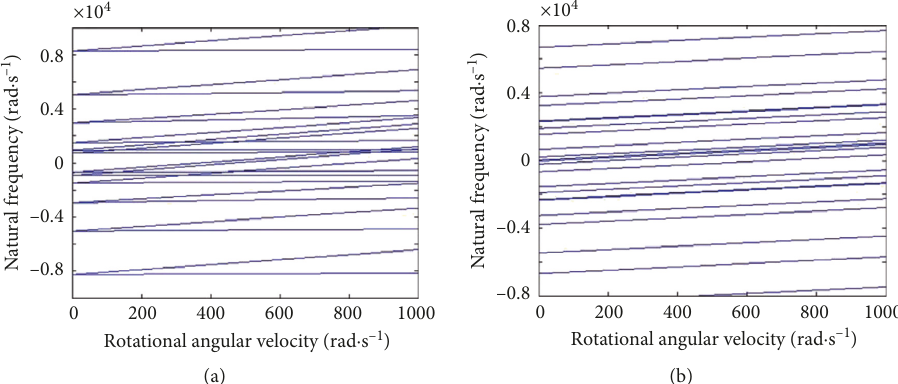
Figure 5: Coupled natural frequency of the shaft transverse vibration: (a) flexible shaft and rigid disk system and (b) flexible shaft and elastic disk system.